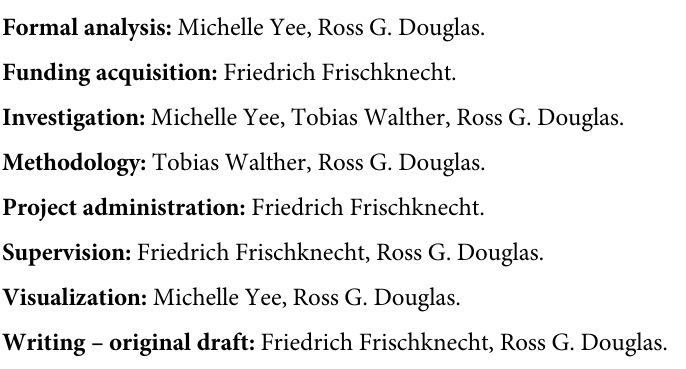
(TIF) S7 Fig. Coarse-grained protein level estimations of mutants analysed with the actin chro- mobody. ( A) Individual readings from separate replicates (individual imaging sessions) for each parasite line. Each data point reflects a background subtracted front and back sporozoite intensity normalized to the average wild-type control. Note that N41H median intensities were variable between duplicate imaging sessions. (B) Data of replicates in (A) combined. Red line indicates median. Mutants generally did not have major changes in their normalized fluores- cence levels, with the exception of N41H which might have reduced functional protein levels. that likely reflects assay limitations and experimental variation despite being statistically signif- icant. (TIF) S1 Data. Numerical data used to generate plots in figures. (XLSX) S1 Table. Primers used in this study.